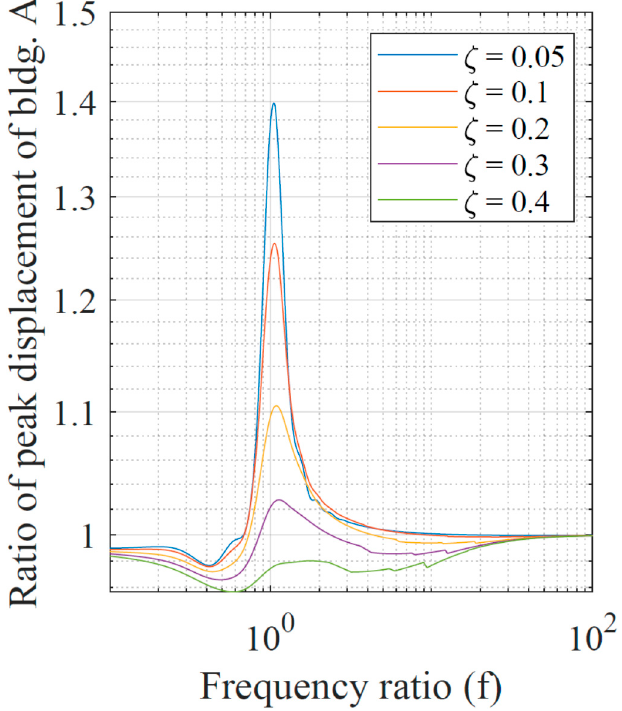
Figure 4. The ratio of maximum displacement of building A when the two buildings are connected by a viscous dashpot and an STMD.